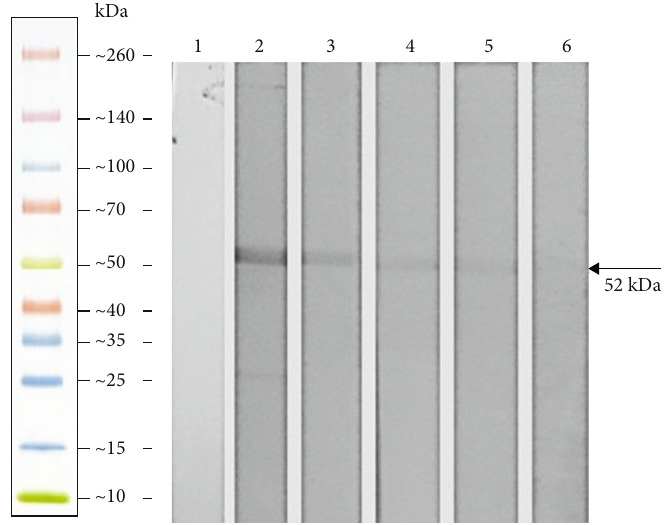
Figure 6: Titer of polyclonal antibodies generated against rNTHiENO. Titration by western blot of the antibodies generated against the recombinant protein. rNTHiENO was migrated on SDS-polyacrylamide gels, and after that, the membranes were electrotransferred to nitrocellulose membranes; as a fi rst antibody, the polyclonal antibody generated at di ff erent dilutions was used; as a secondary antibody, a goat anti-rabbit alkaline phosphatase-labeled IgG was used. The image is representative of at least three independent experiments. Lane 1: preimmune serum. Lane 2: dilution 1: 1000. Lane 3: dilution 1 :10000. Lane 4: dilution 1 :20000. Lane 5: dilution 1:30000. Lane 6: dilution 1 :40000. The weight of the recombinant protein is indicated with an arrow.